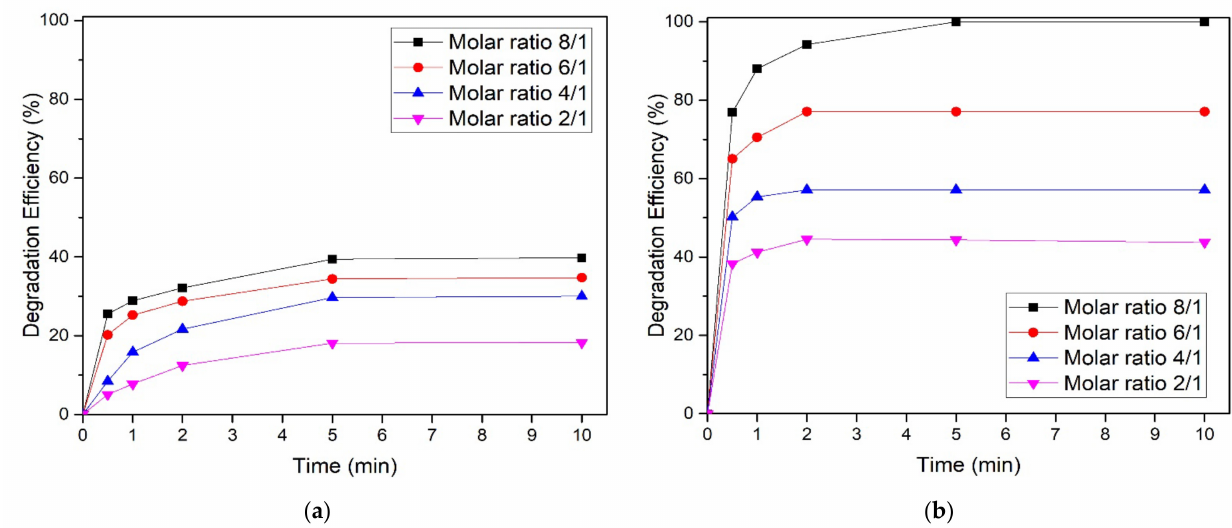
Figure 5. Effect of molar ratio on the removal of ( a ) bromobenzene and ( b ) chlorobenzene. (Experimental conditions: initial pH 6.8, C o = 0.010 mM and temperature = 25 ◦ C).